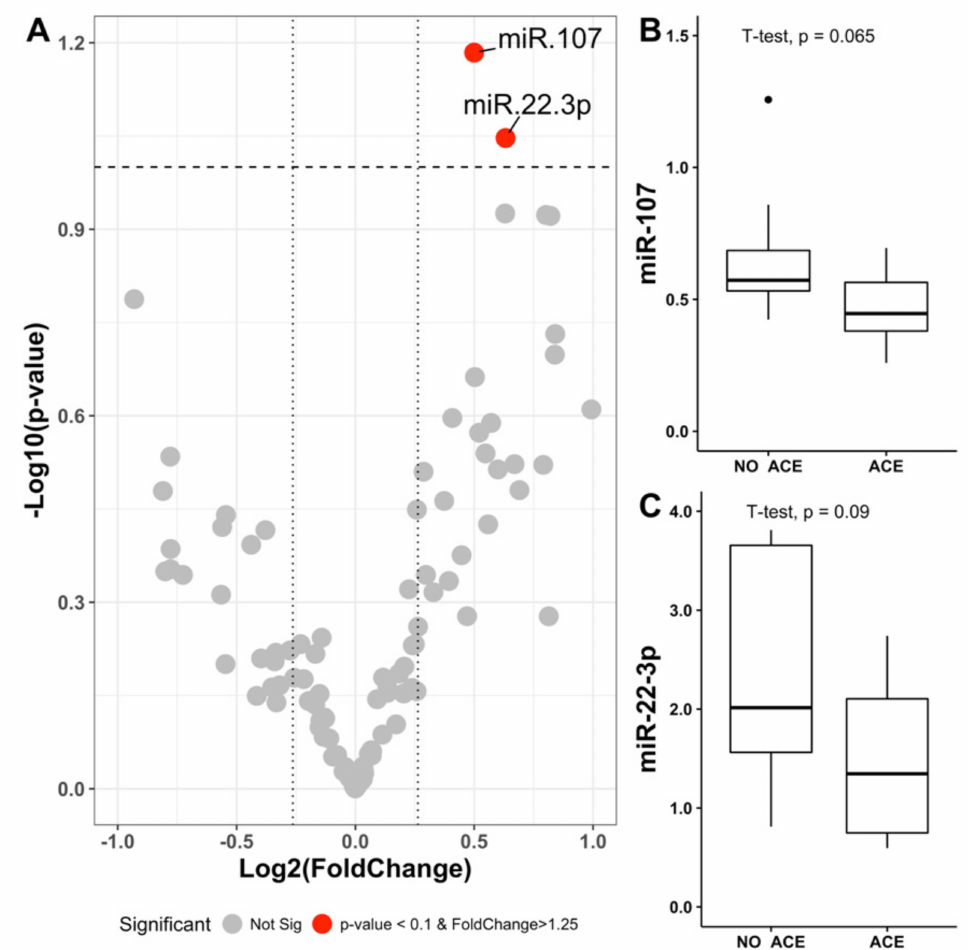
Figure 1. Levels and selection of miRNAs in the pilot study. ( A ) Volcano plot representing the fold change values in logarithm of base 2 (X-axis) and the p -values in logarithm of base 10 (Y-axis). ( B , C ) Box plots representing the miRNA levels selected for meeting the criteria of p -value less than 0.1 and fold change greater than 1.25. ACE = adverse cardiovascular